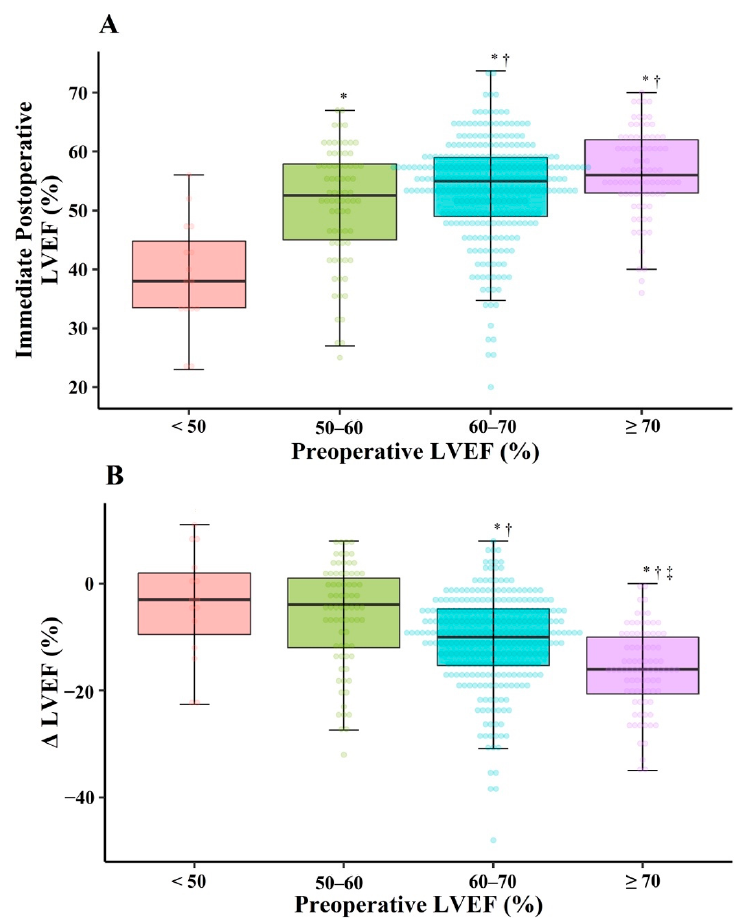
Figure 2. Immediate postoperative LVEF ( A ) and ∆ LVEF ( B ) after mitral valve repair for chronic primary mitral regurgitation according to preoperative LVEF. LVEF: left ventricular ejection frac-